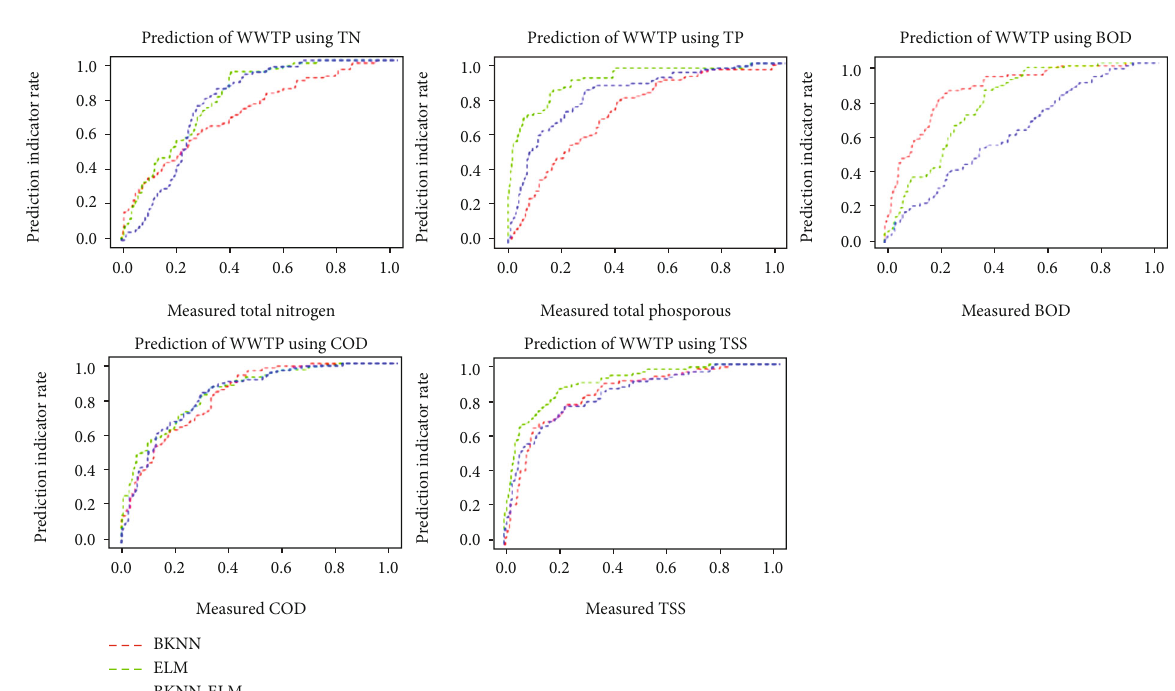
Figure 6: Statistical analysis of prediction of various indicators.